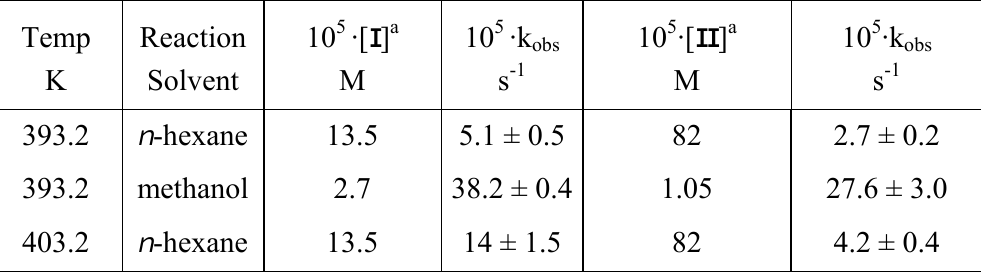
Table I . First-Order Rate Constant Values for the Thermal Decomposition Reactions of Trioxanes I and II in n -Hexane and Methanol